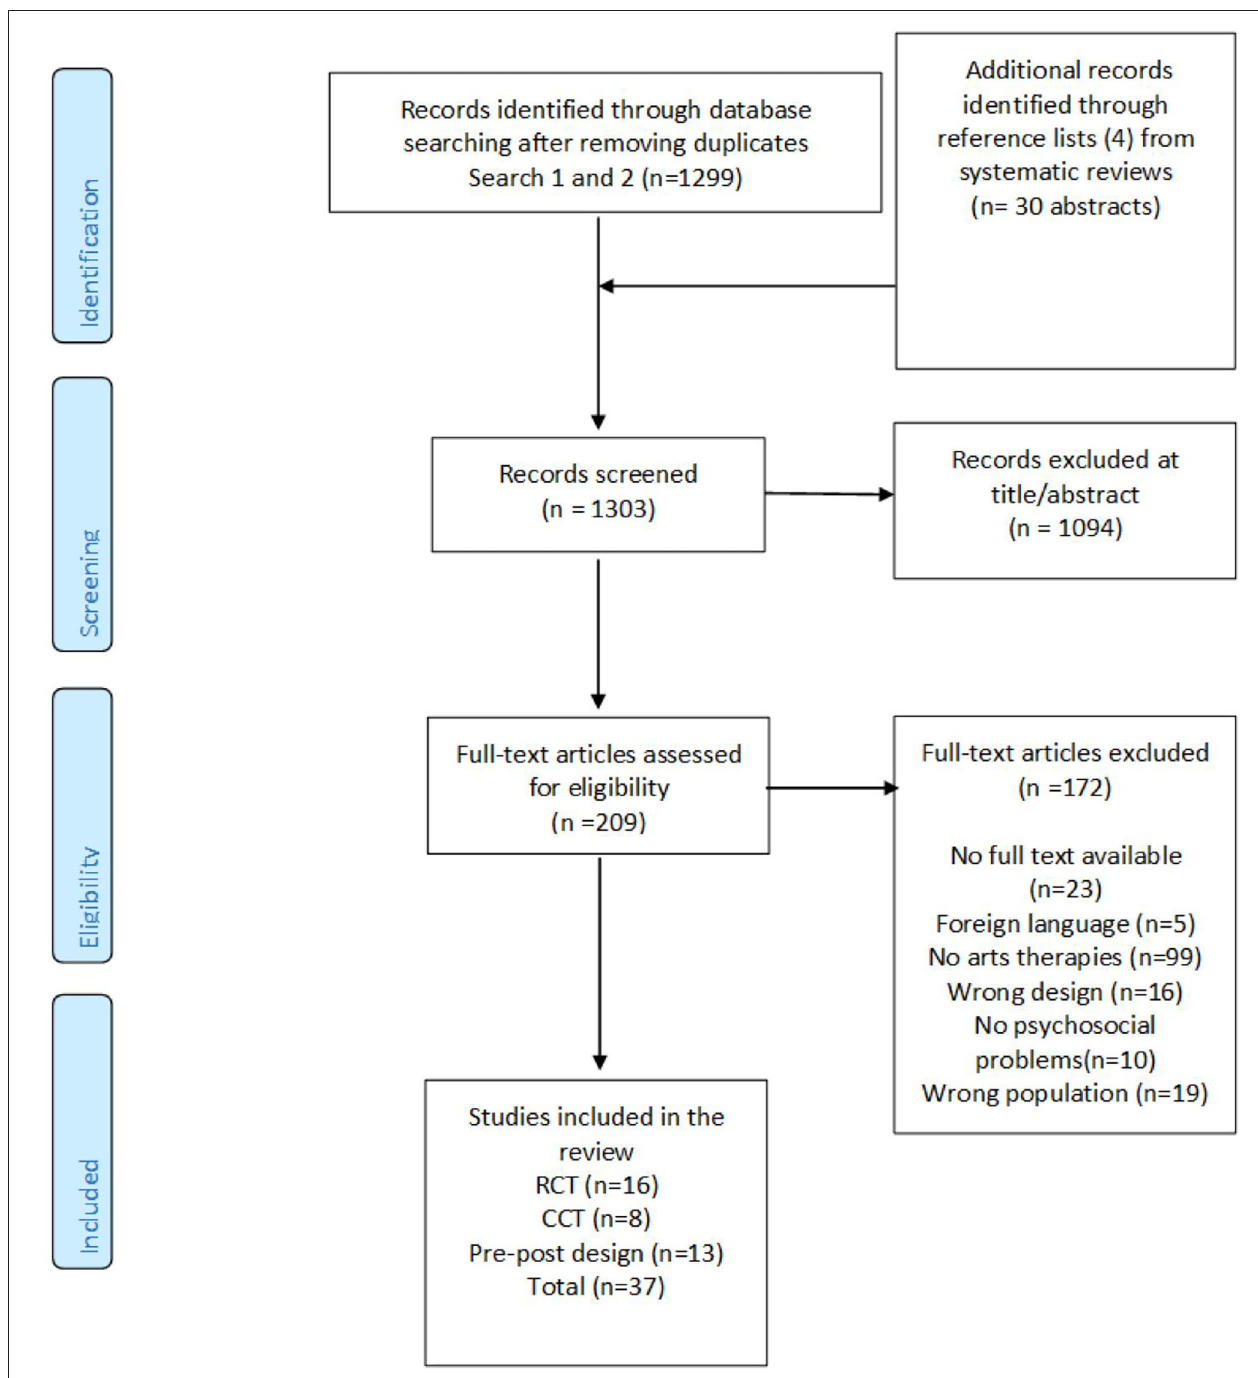
FIGURE 1 | PRISMA (Preferred Reporting Items for Systematic Reviews and Meta-Analyses) flow